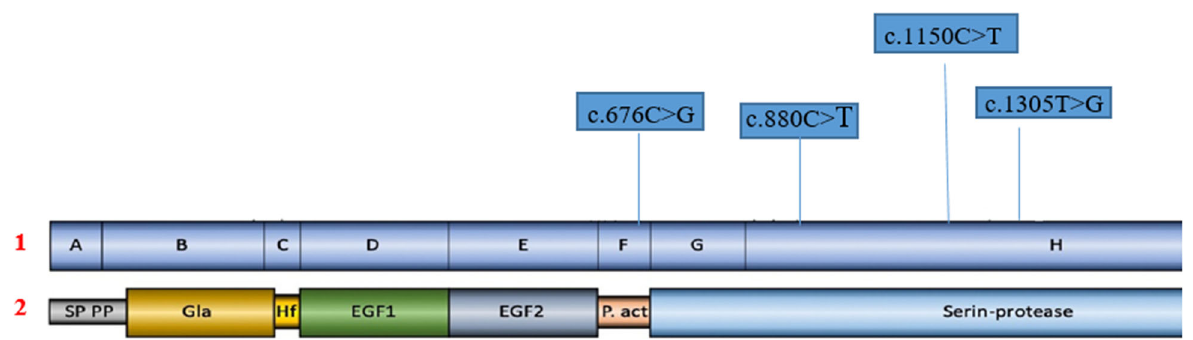
Fig. 2 Distribution of variants in F9 in Egyptian patients. (1) Schematic representation of the F9 gene showing its 8 exons (A-H), with the location of the mutations found in the patients studied, (2) Factor IX protein; SP domain, signal peptide; PP, Pro peptide; Gla, gamma-carboxy-glutamic domain; EGF1 and EGF2, domains with homology to epidermal growth factors 1 and 2